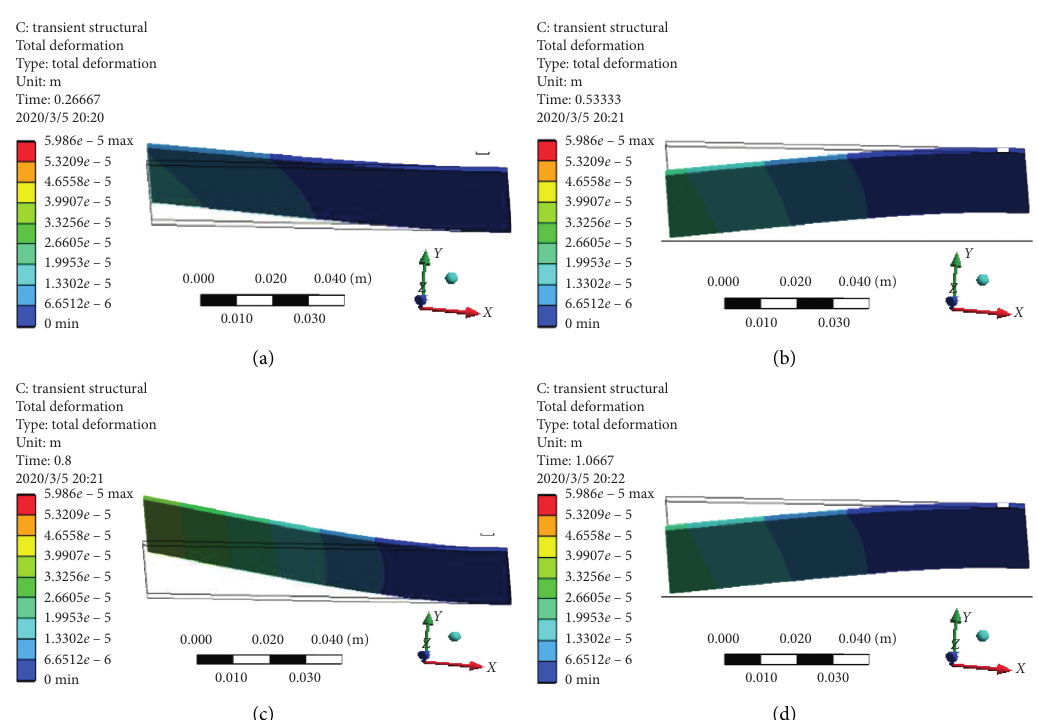
Figure 11: Deformation of the piezoelectric cantilever beam. (a) t � 0.267s. (b) t � 0.533s. (c) t � 0.800s. (d) t � 1.067s.